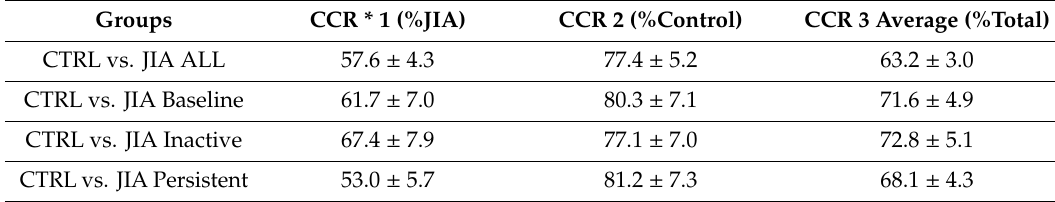
Table 7. PLS-DA models in DCV of low-level fused data